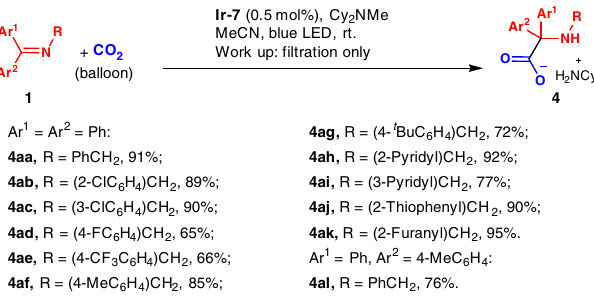
Fig. 3 Chromatography-free syntheses. Preparation of α -amino acids using CO 2 and ketimines without chromatographic puri fi